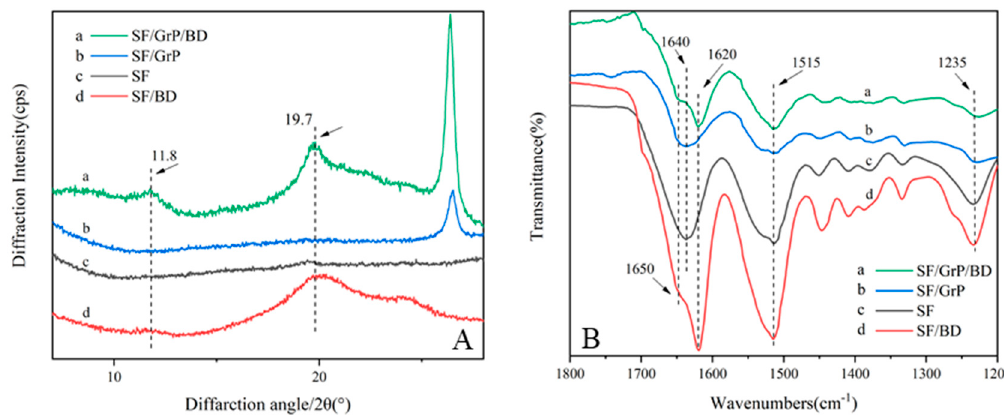
Figure 4. ( A ) XRD and ( B ) ATR-FTIR patterns of SF, SF / BD, SF / GrP, SF / GrP / BD films. Figure 4. XRD and ATR-FTIR patterns of SF, SF/BD, SF/GrP, SF/GrP/BD films.